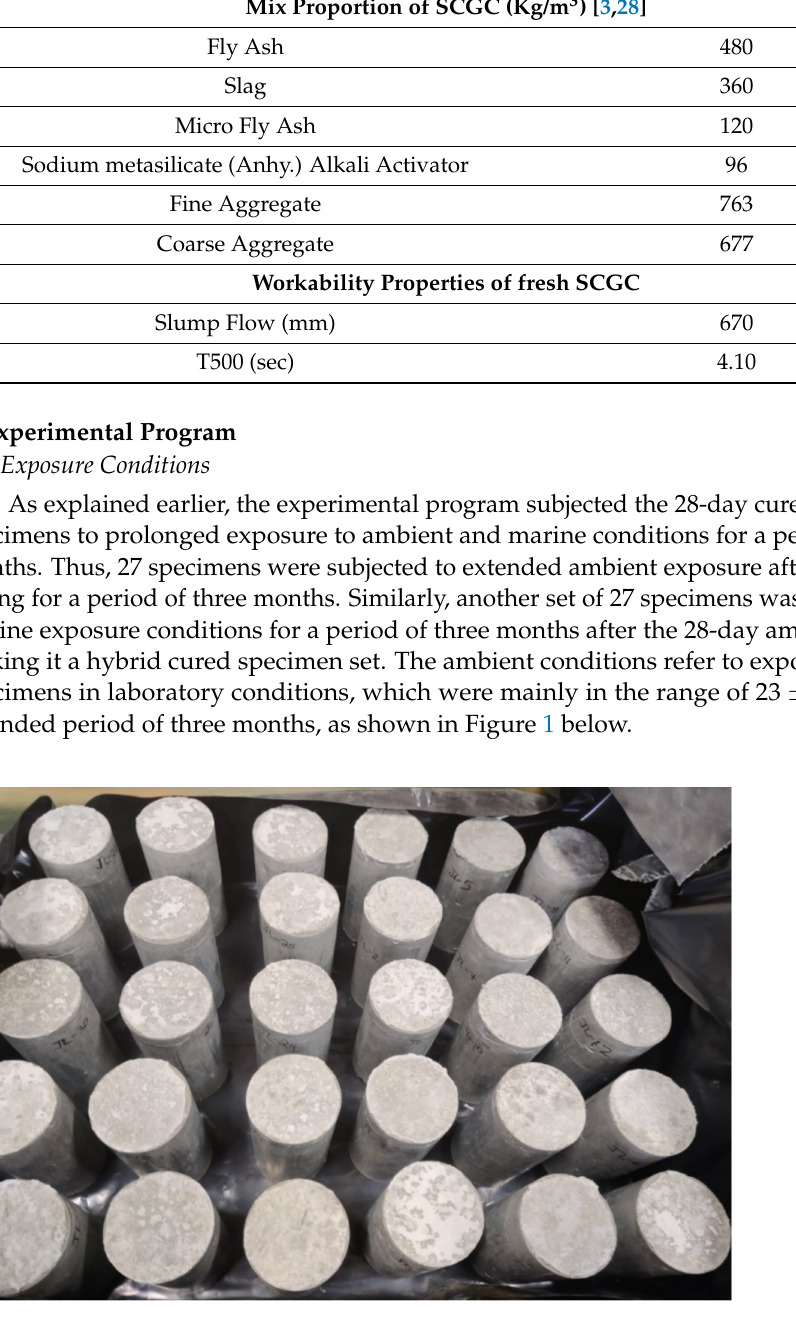
Figure 1. Specimens under ambient exposure